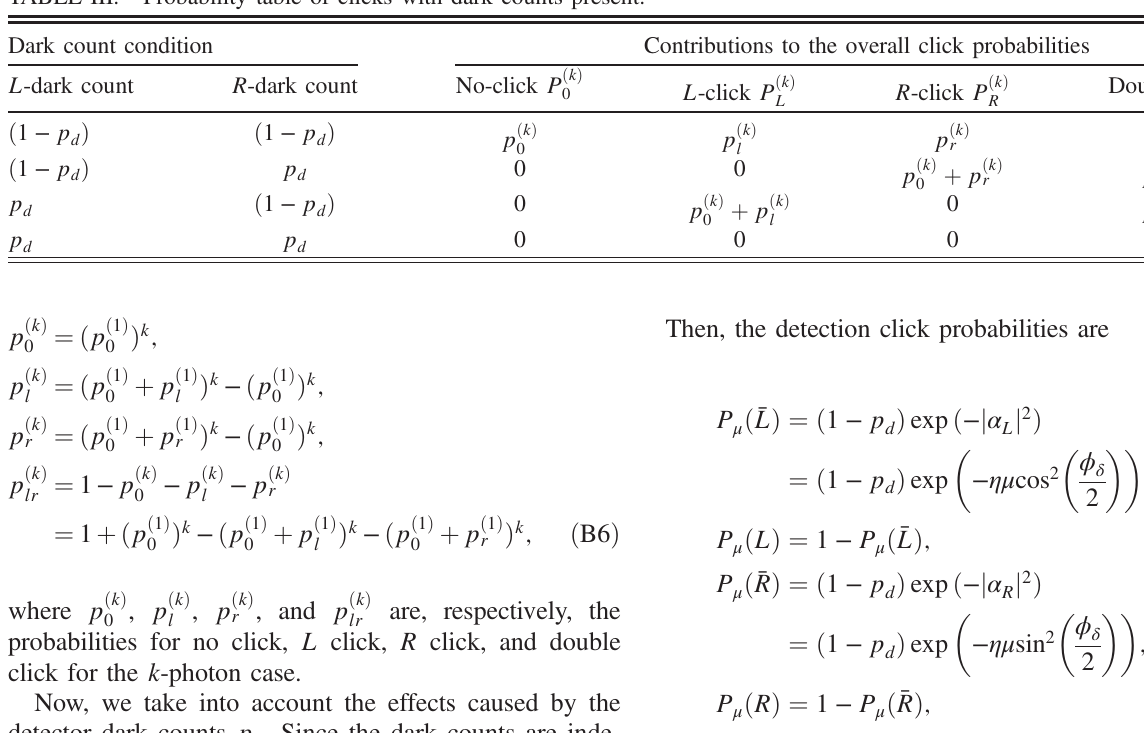
TABLE III. Probability table of clicks with dark counts